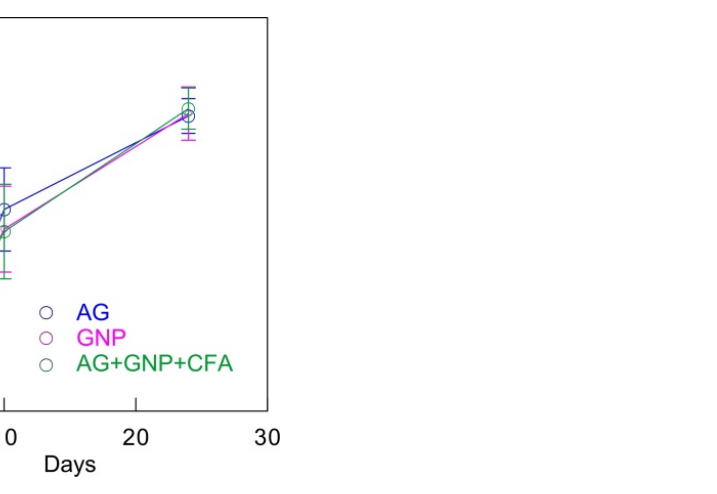
Figure 7. Tumor growth dynamics after immunization and subsequent tumor cell transplantation.